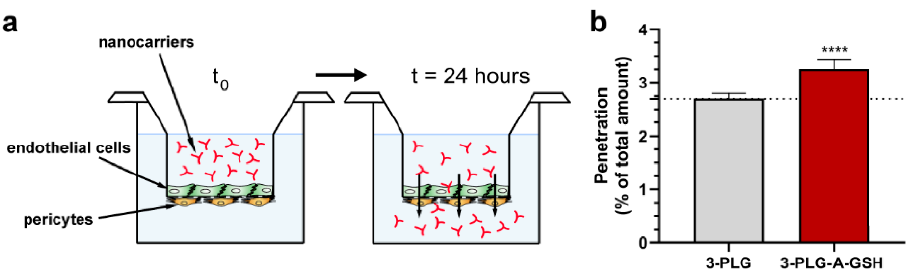
Figure 8. Penetration of non-targeted (3-PLG) and alanine–glutathione-targeted (3-PLG-A-GSH) nanocarriers across the human co-culture model of the blood–brain barrier (24 h incubation, 50 μ g/mL, 37 °C). ( a ) Schematic drawing of the experimental set-up. ( b ) Penetration of 3-PLG and 3-PLG-A-GSH across the blood–brain barrier model. Values are means ± SD and given as a percentage of the total nanocarrier amount in the upper, donor compartment at t = 0. Statistical analysis: unpaired t -test; **** p < 0.0001; n = 6.